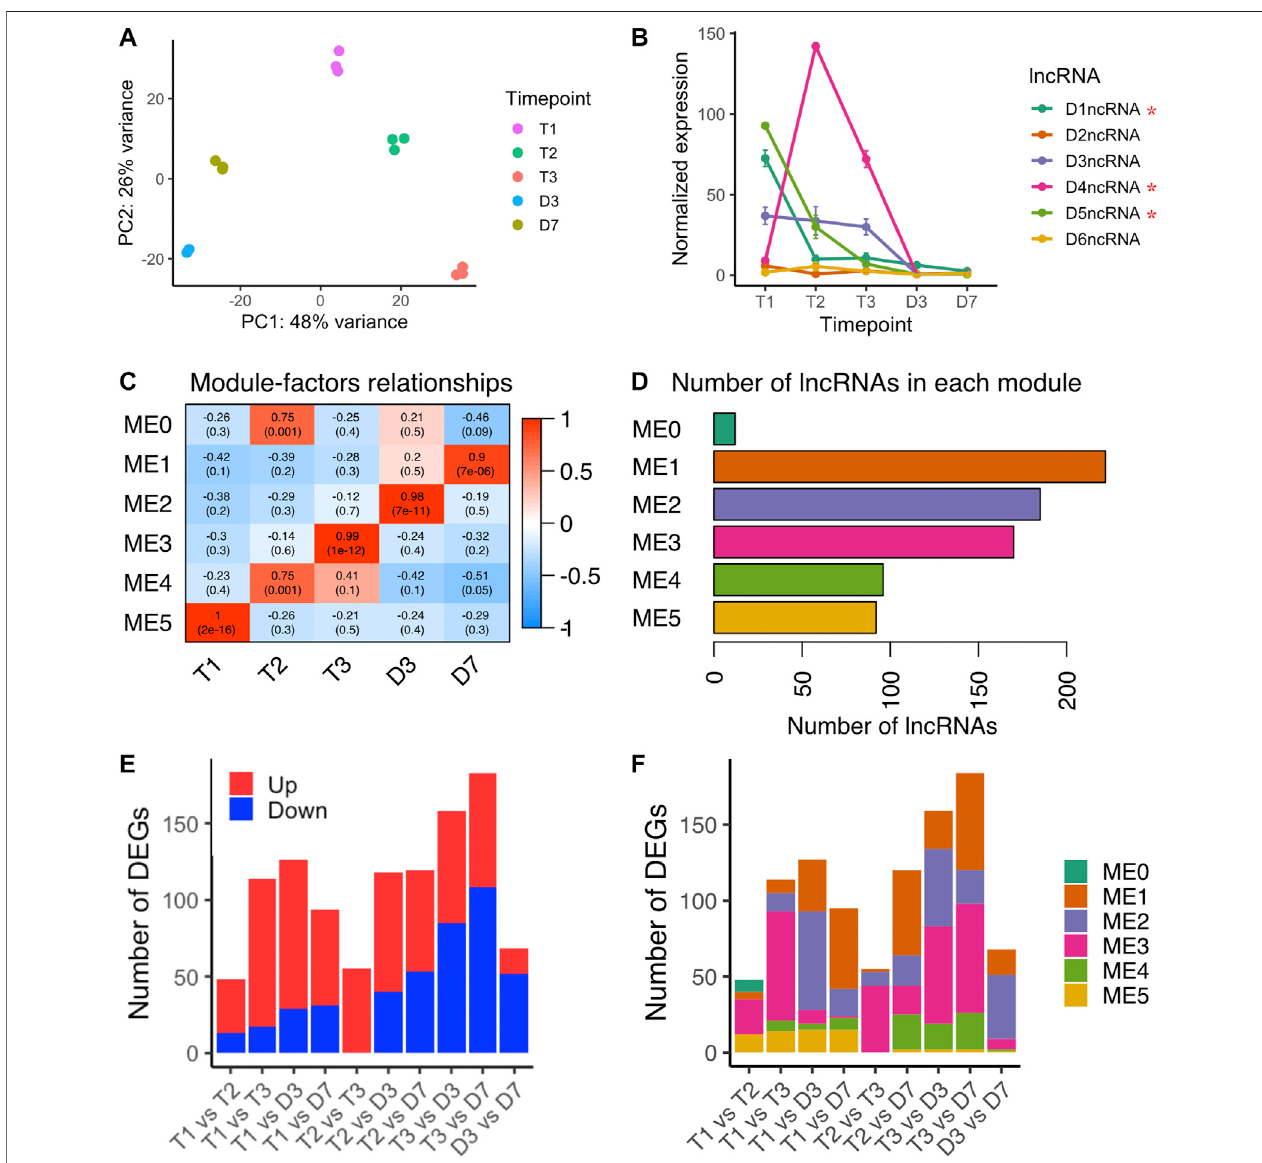
FIGURE 6 | lncRNA expression variances during bud dormancy release (A) PCA analysis of lncRNA transcriptome variances over fi ve time points (B) Expression pro fi les of six intronic non-coding RNAs in six DAM genes (mean ± SE). Red stars indicated the lncRNAs were differentially expressed between endodormancy and ecodormancy (C) Module-traitrelationshipsbetweenco-expressionmodulestotimepoints (D) ThenumberoflncRNAgenesincludedineachco-expressionmodule (E) The number of signi fi cantly upregulated lncRNA genes (red) and downregulated lncRNA genes (blue) in the pairwise comparison between time points (F) The number of differentially expressed lncRNA genes in each co-expression